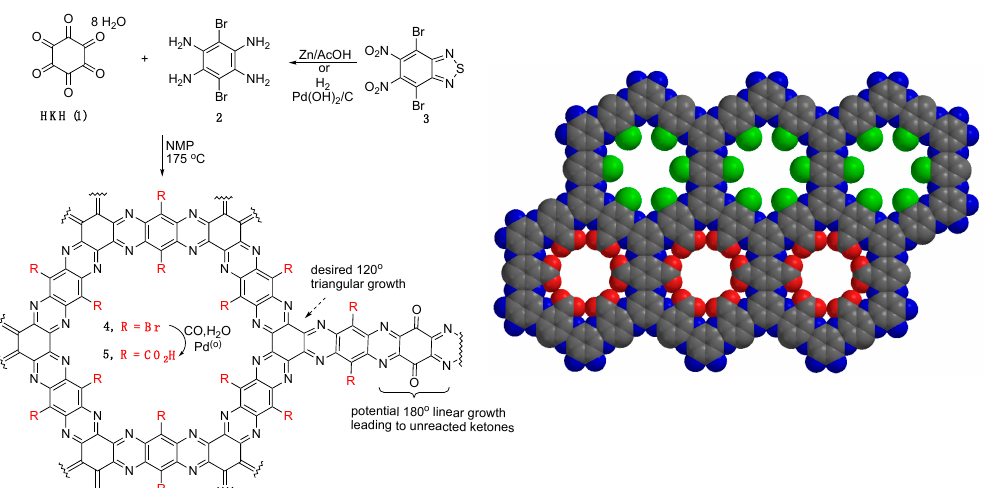
Figure 1. Left: synthetic routes for the synthesis of covalent organic frameworks (COFs) 4 and 5 , with a possible linear defect. Right: space-filling model with bromines in green, top and CO 2 H moieties in red, bottom.